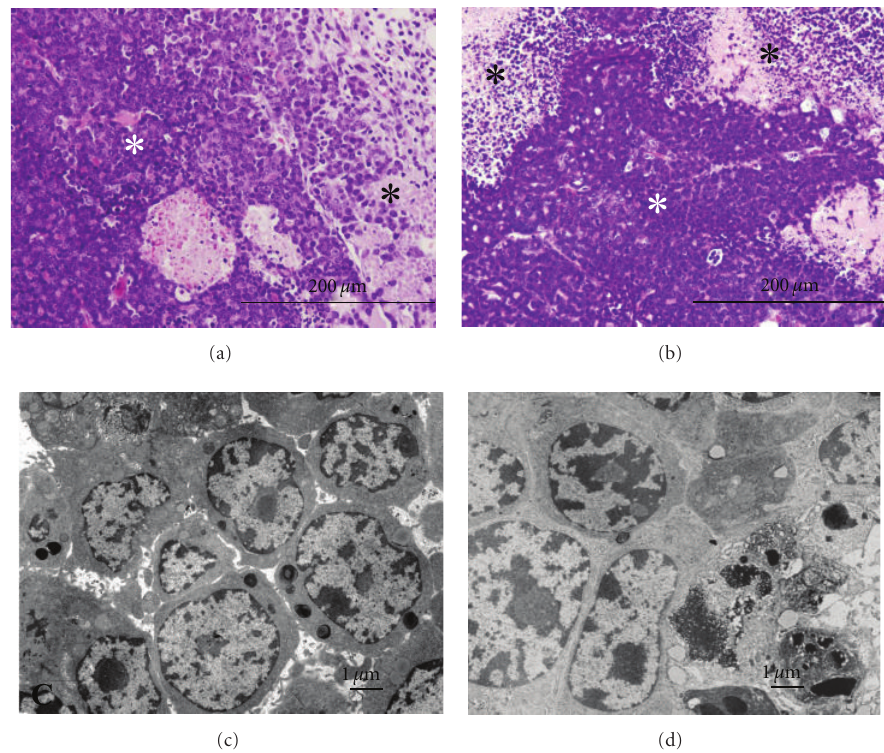
Figure 2: Histopathology of the inoculated tumors at 10 weeks postinoculation. H&E staining (a and b) show viable region (white ∗ ) and necrotic region (black ∗ ) in BJMC338 tumor (a) and BJMC3879 tumor (b). TEM micrographs (c and d) indicate tumor cells in the viable region of BJMC338 tumor (c) and BJMC3879 tumor (d).